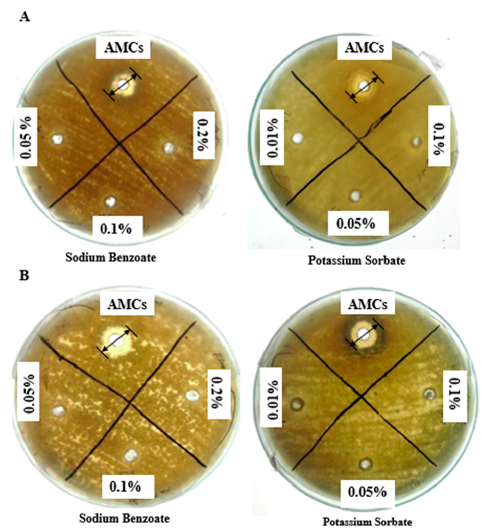
Figure 2. Inhibition zones of antifungal potential of L. coryniformis BCH-4 ethyl acetate extracted ( A ) A. fumigatus and ( B ) A. flavus at 30 ◦ C after 48 h of incubation. Well diameter was 8 mm.